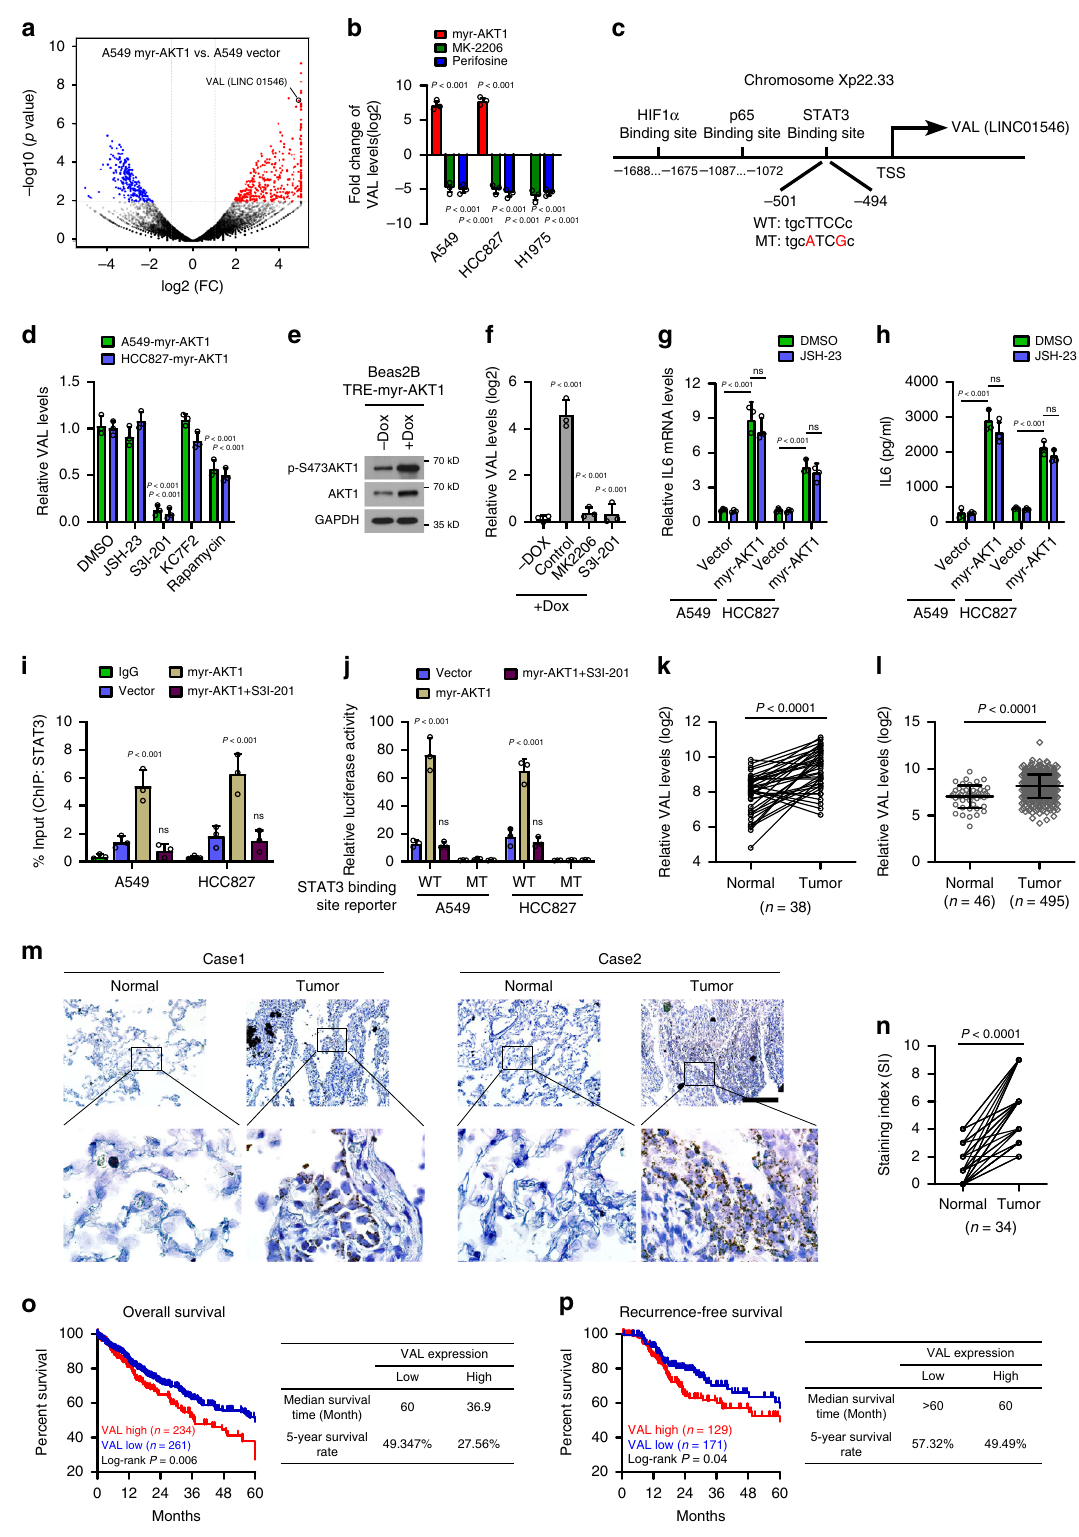
(Supplementary Fig. 1g). As expected, stimulation of LAD cells with recombinant IL6 protein also signi fi cantly induced VAL expression, and STAT3 inhibitor greatly reversed, while AKT inhibitor slightly compromised IL6-induced VAL expression (Supplementary Fig. 1i). In parallel, both IL6 stimulation and overexpression of constitutively active STAT3